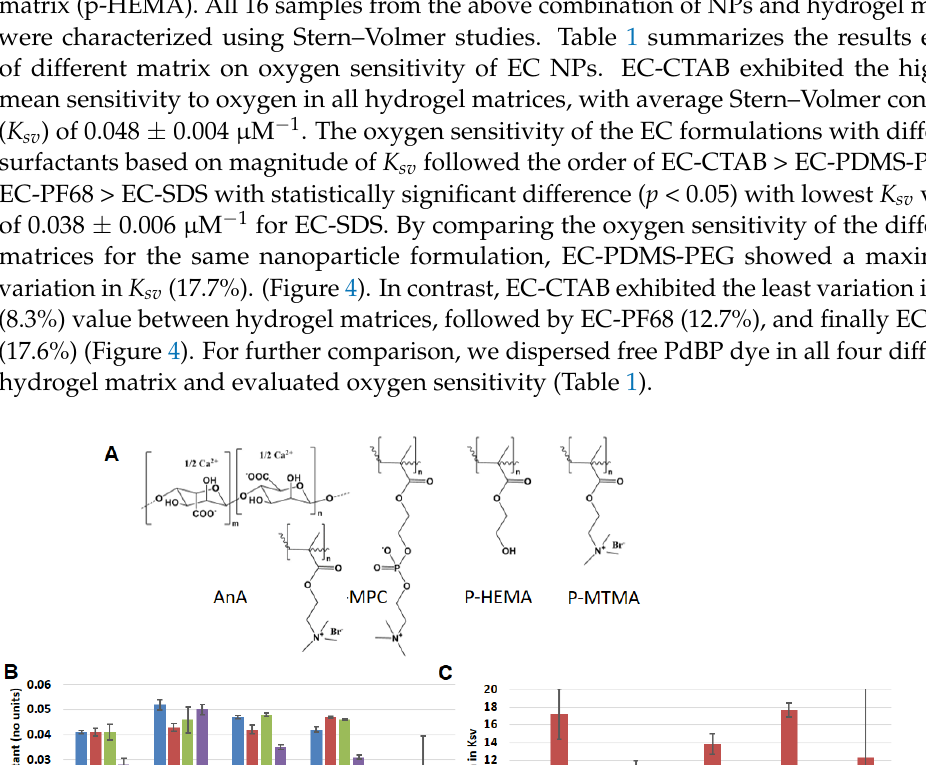
Table 1. The effect of hydrogel matrix on oxygen sensitivity of ethyl cellulose nanoparticles (EC NPs) coated with different surfactants.